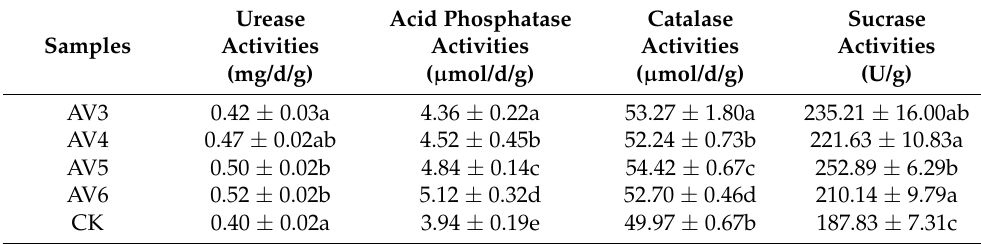
Table 2. Soil enzyme activities among the examined